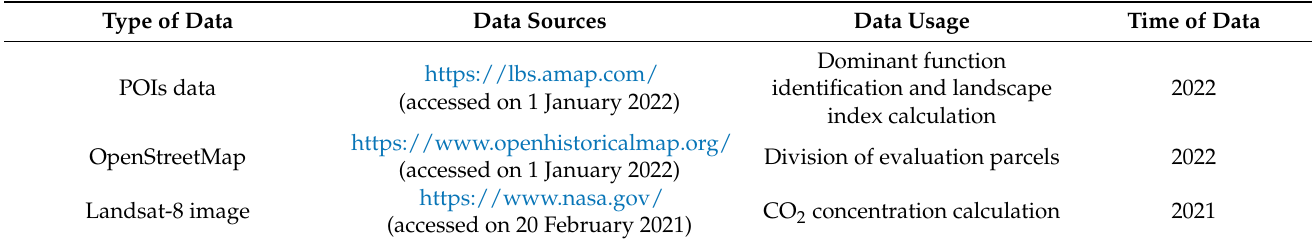
Table 1. List of data sources.